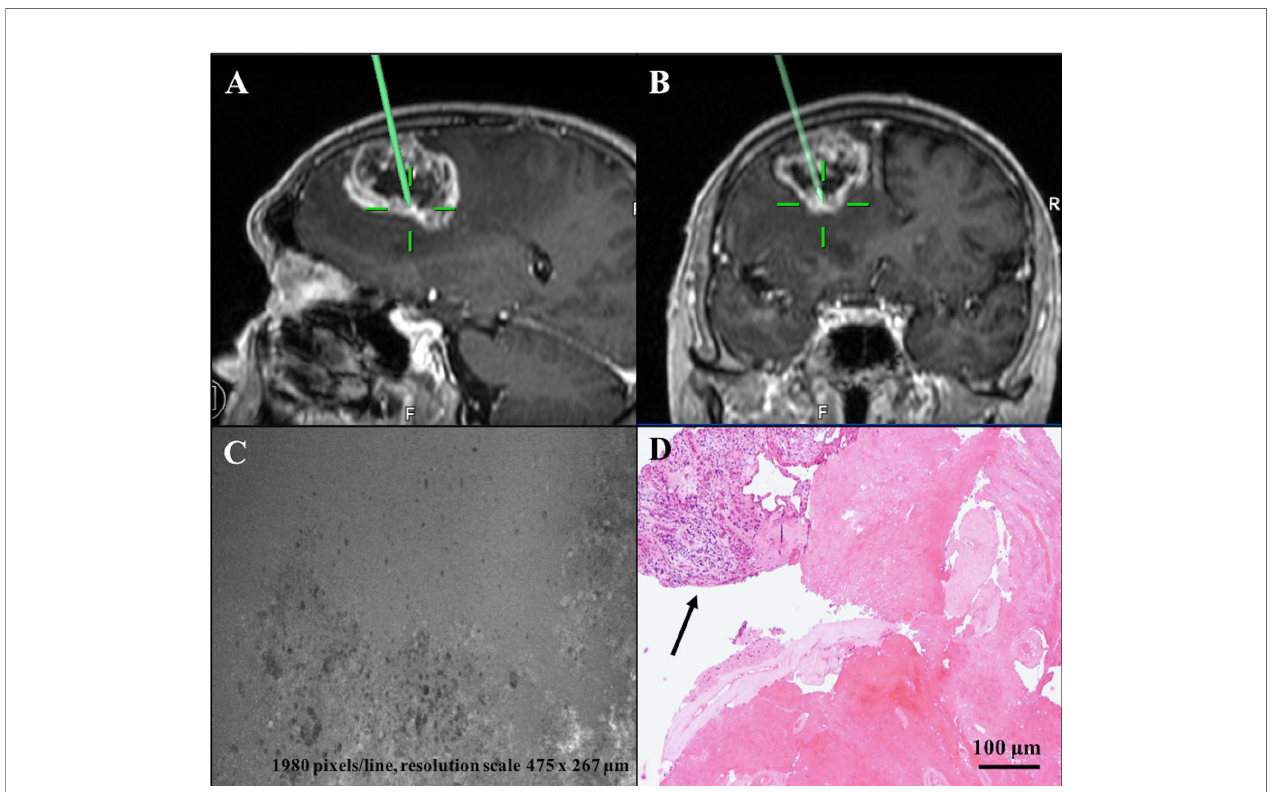
FIGURE 4 | Diagnostic discordant case: left frontal GBM (case n. 6). (A, B) Sagittal and coronal T1 after contrast administration images showing location of tissue biopsies sampled at tumor central core, where CONVIVO ® scan (C) disclosed «necrosis» (amorphous area with few cells and intermediate fl uorescence background). (D) De fi nitive histology of the sample showing a small part of tumor tissue (black arrow), adjacent to amorphous material with only some “ ghost ” cells and vessels, consistent to necrosis and corresponding at the area analyzed by CONVIVO ® . Taken together, these features set out the diagnosis of GBM. In this speci fi c case, the discordant results for both tumor diagnosis and morphological categorization at central core were due to a larger fi eld of observation with the optical microscope used at the permanent section